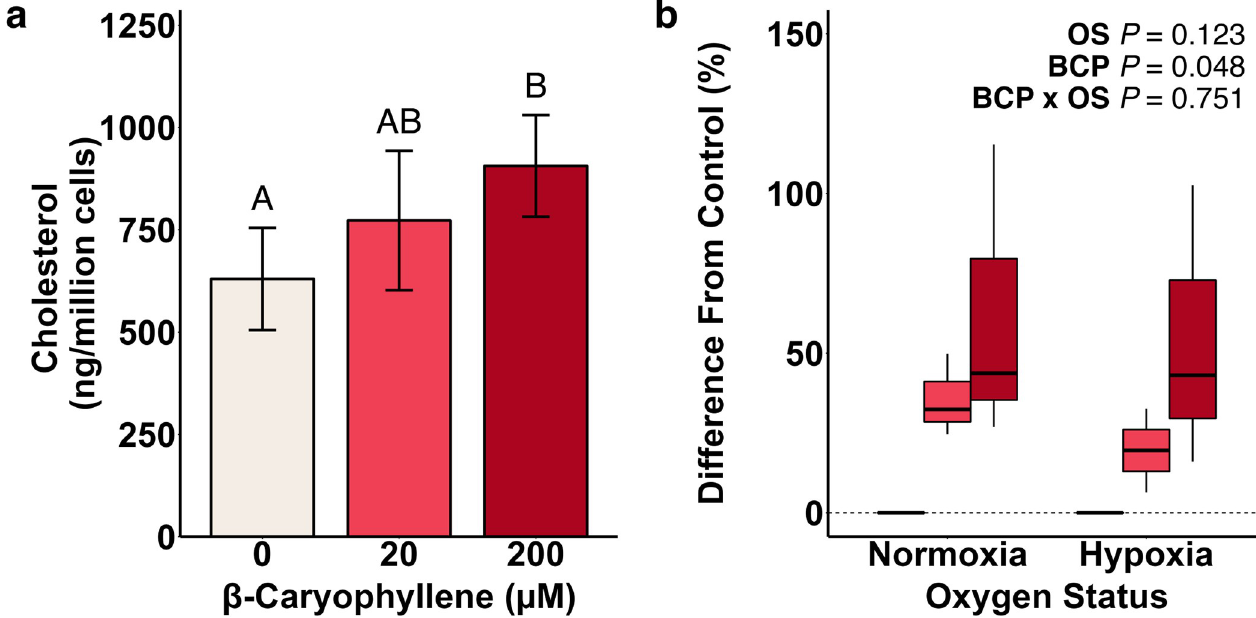
Fig 3. Cholesterol content of UFH-001 cells is sensitive to BCP but not hypoxia. UFH-001 cells were exposed to normoxic or hypoxic conditions in the presence of BCP for 16h. At the end of the incubation, cells were washed and processed for lipid extraction as described in Methods. (a) Total cholesterol content by BCP treatment. Bars are means ± S.E.M of 6 biological replicates. Data were log-transformed for statistical analysis; different letters above the bars indicate statistical differences at α � 0.05 from the main effect of BCP in the mixed-model ANOVA. (b) Box-and-whisker plot of cholesterol content expressed as a percent difference from BCP controls. Each box represents 3 biological